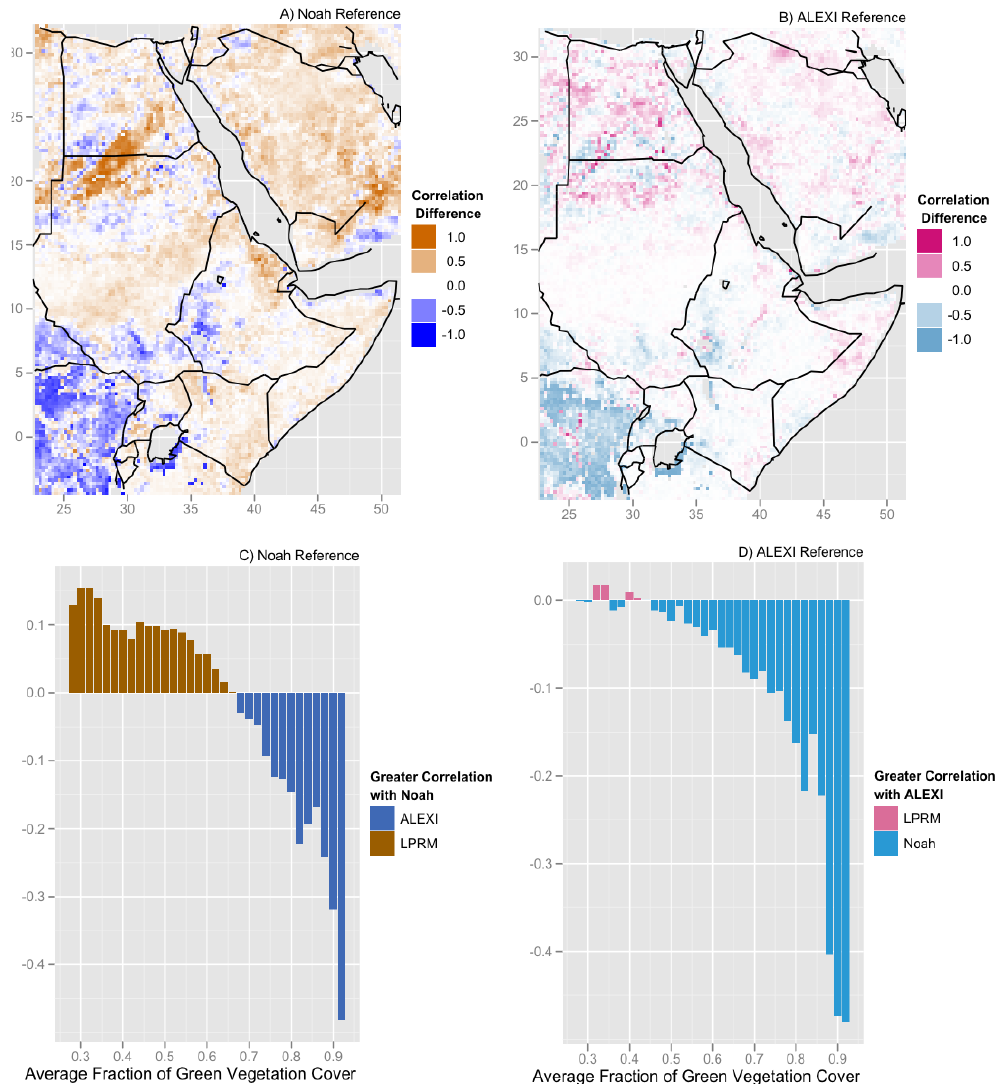
Fig. 6. Anomaly correlation difference using Noah (A, C) and ALEXI (B, D) as reference datasets. Areas shaded in brown or pink represent a greater correlation between LPRM and the reference dataset. (A) and (B) show the spatial distribution of correlation differences, while (C) and (D) show correlation differences as a function of the average fraction of green vegetation during the rainy seasons.